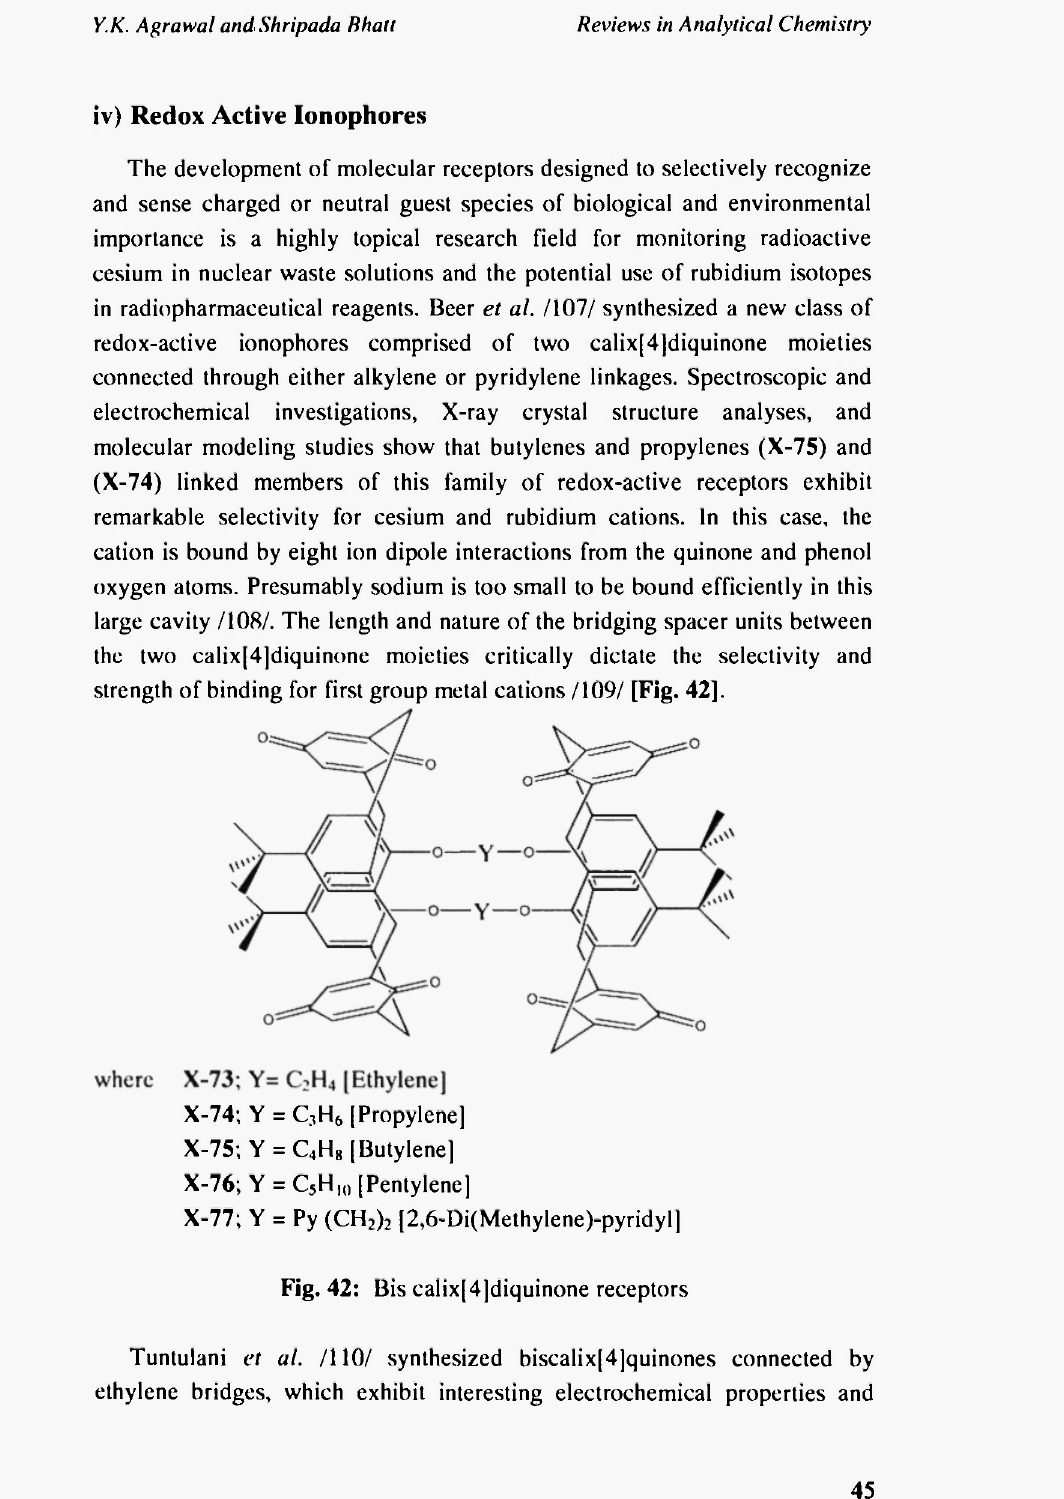
Fig. 42: Bis calix[4]diquinone